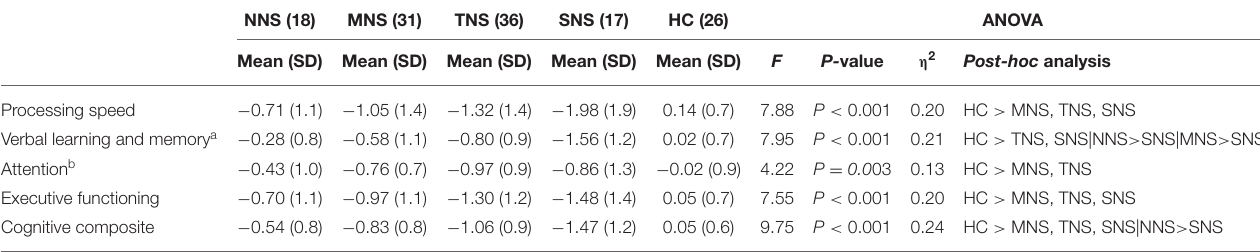
TABLE 2 | Baseline cognitive scores for the different patient groups and healthy